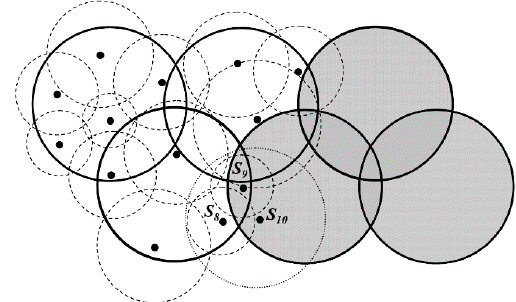
Figure 7. Distributed sleep scheduling strategy in each DGA.